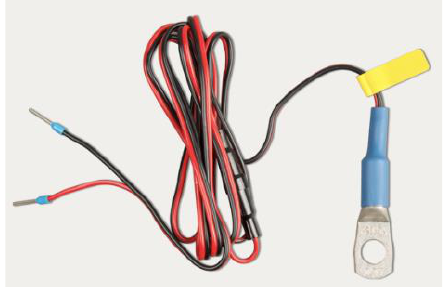
Figure 10. ASS000100000 temperature sensor.